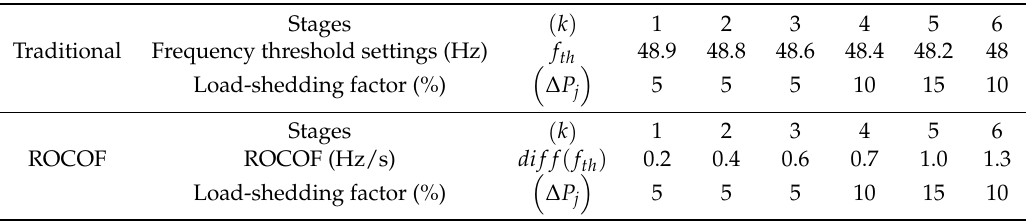
Table A1. Threshold settings of the considered UFLS techniques for comparison with the proposed method